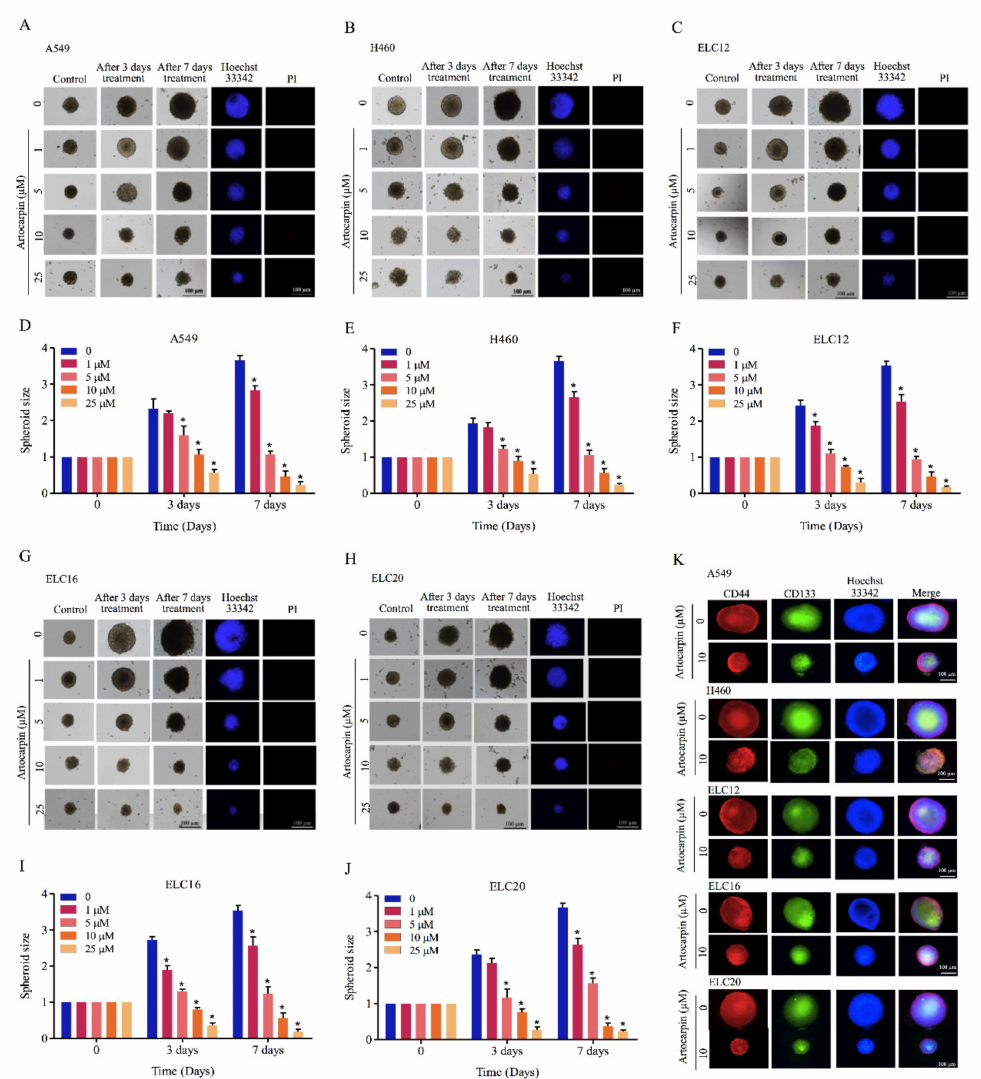
Figure 4. Artocarpin suppresses CSC growth in a CSC-rich population. ( A , D ) A549, ( B , E ) H460, ( C , F ) ELC12, ( G , I ) ELC16, and ( H , J ) ELC20 secondary spheroids were selected and treated with artocarpin (0–10 µ M) for 3 and 7 days. Phase-contrast images of secondary spheroids at days 0, 3, and 7 and untreated cells were determined. At 7 days, single spheroid was stained with Hoechst 33342 to aid visualization of the cell nucleus. ( K ) The expression levels of CD44 and CD133 were determined using the anti-CD44 and anti-CD133 antibody, followed by the Alexa Fluor 594-labeled secondary antibody, and Alexa Fluor 488-labeled secondary antibody and determined using fluorescence microscopy. Data represent the mean ± SD ( n = 3). * p < 0.05, versus non-treated